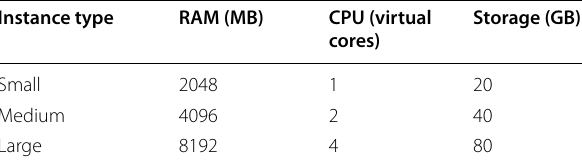
Table 3 Resources quantity specified by instance types used for